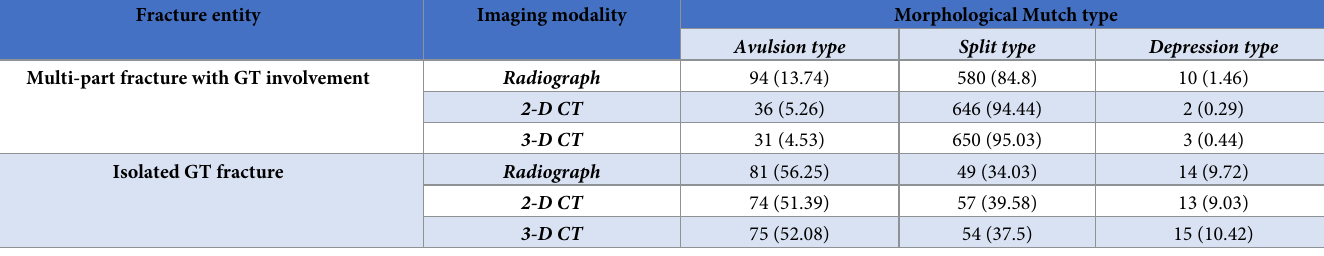
Table 3. Total amount of observers‘selections (n (%)) for both fracture groups, and each imaging